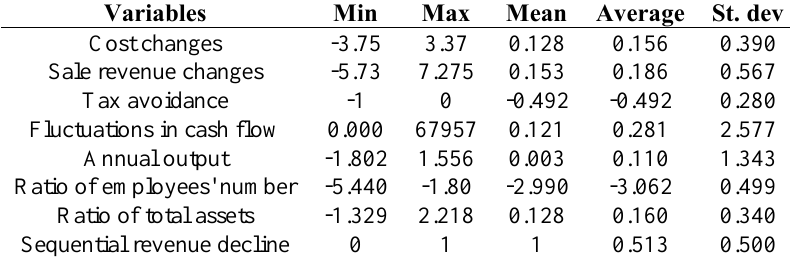
Table 1. Descriptive statistics of study's variables